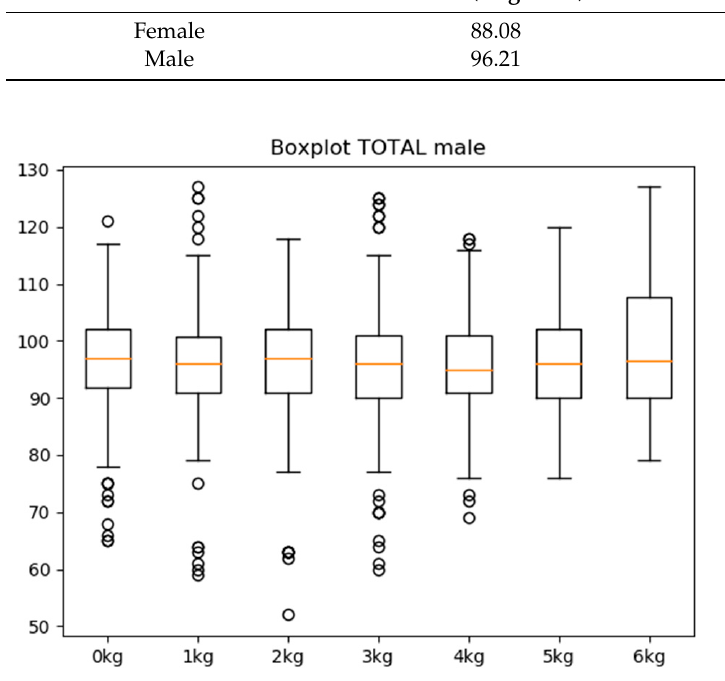
Figure 2. Variability of joint width by weight (male).